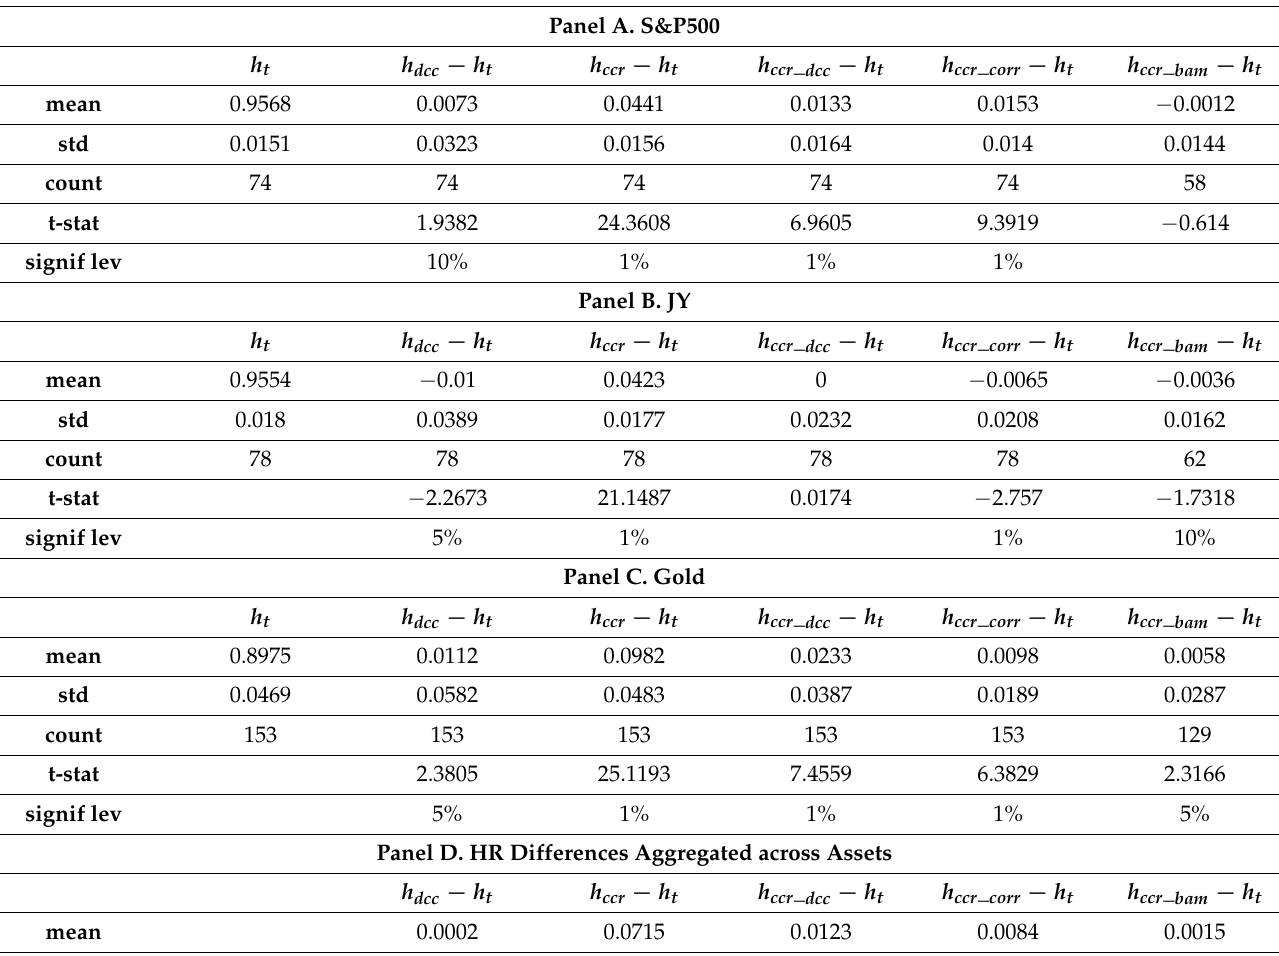
Table 1. The Benchmark Hedge Ratios and Differences from them. A. The Benchmark Hedge Ratio and Differences from it When h t is the Benchmark. Panel A.